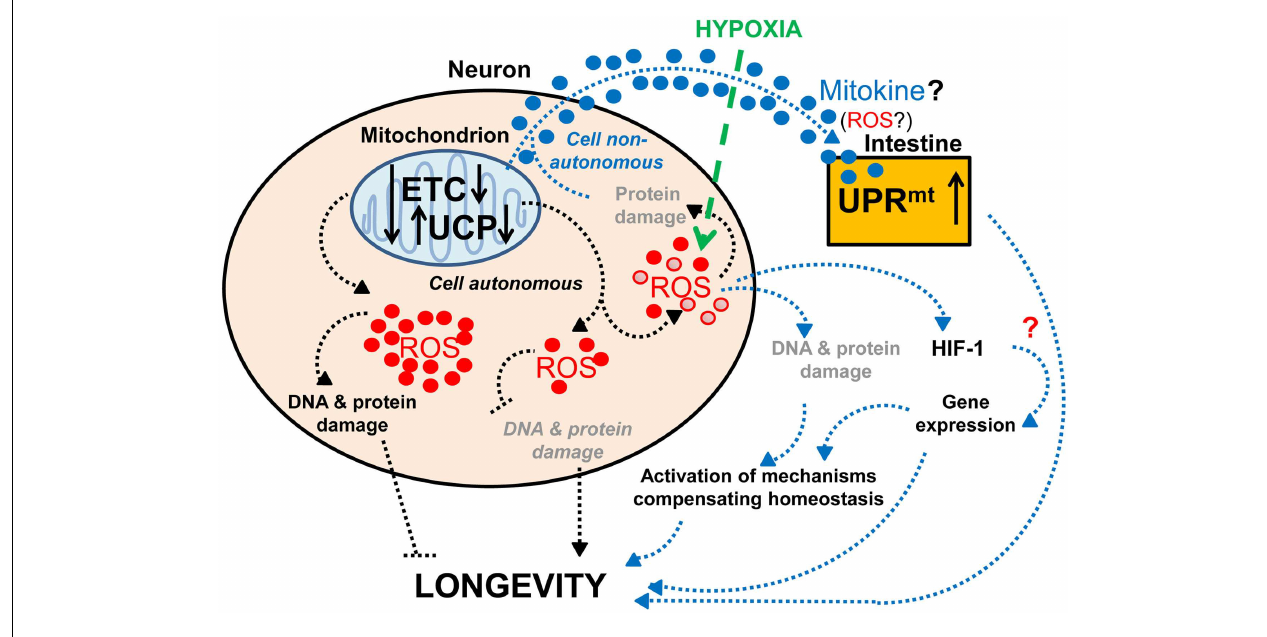
FIGURE 2 | Effects of neuronal mitochondrial UCP and the electron transport chain on longevity . Lifespan is modulated by altered mitochondrial function in neurons: a lower level of UCP and electron transport chain (ETC) expression lengthens lifespan, whereas a higher level of UCP and ETC expression has the opposite effect on lifespan (Fridell et al., 2005; Rea et al., 2007; Copeland et al., 2009; Humphrey et al., 2009; Durieux et al., 2011).The lifespan increase observed with mild mitochondrial dysfunction may hypothetically be due to (1) a decrease in ROS production and DNA and protein damage (denoted in gray and italics) or (2) a mild increase in ROS production and DNA and protein damage (denoted in gray), which can activate